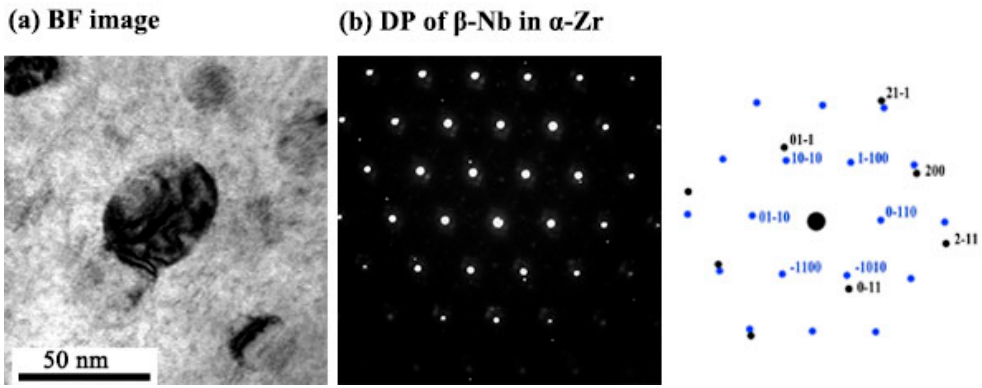
Figure 9. ( a ) Bright field image and ( b ) diffraction pattern of β –Nb in α –Zr at 100 °C after irradiation showing no amorphization of β –Nb. The diffraction pattern was taken at z = [0002] of α –Zr.